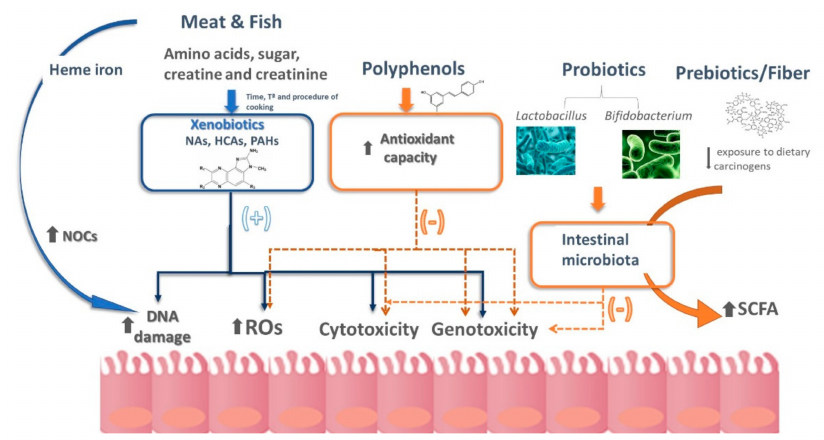
Figure 1. Schematic representation of the di ff erent hypotheses currently available that contribute to explaining the relationship between diet and colorectal cancer. HCAs, heterocyclic amines; NAs, nitrosamines; NOCs, N -nitroso compounds; PAHs, polycyclic aromatic hydrocarbons; ROS, reactive oxygen species; SCFA, short chain fatty acids. More details are explained in the text.